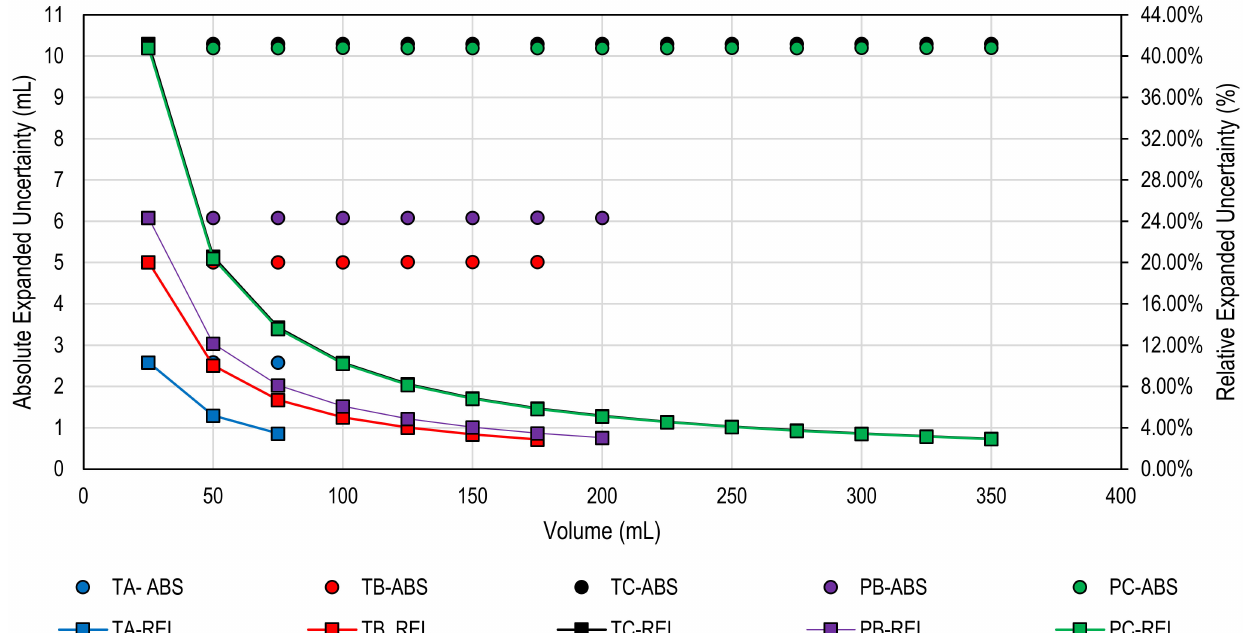
Figure 5. Absolute and relative uncertainty associated with the liquid volume measurements from each tube and pipe from the operational performance